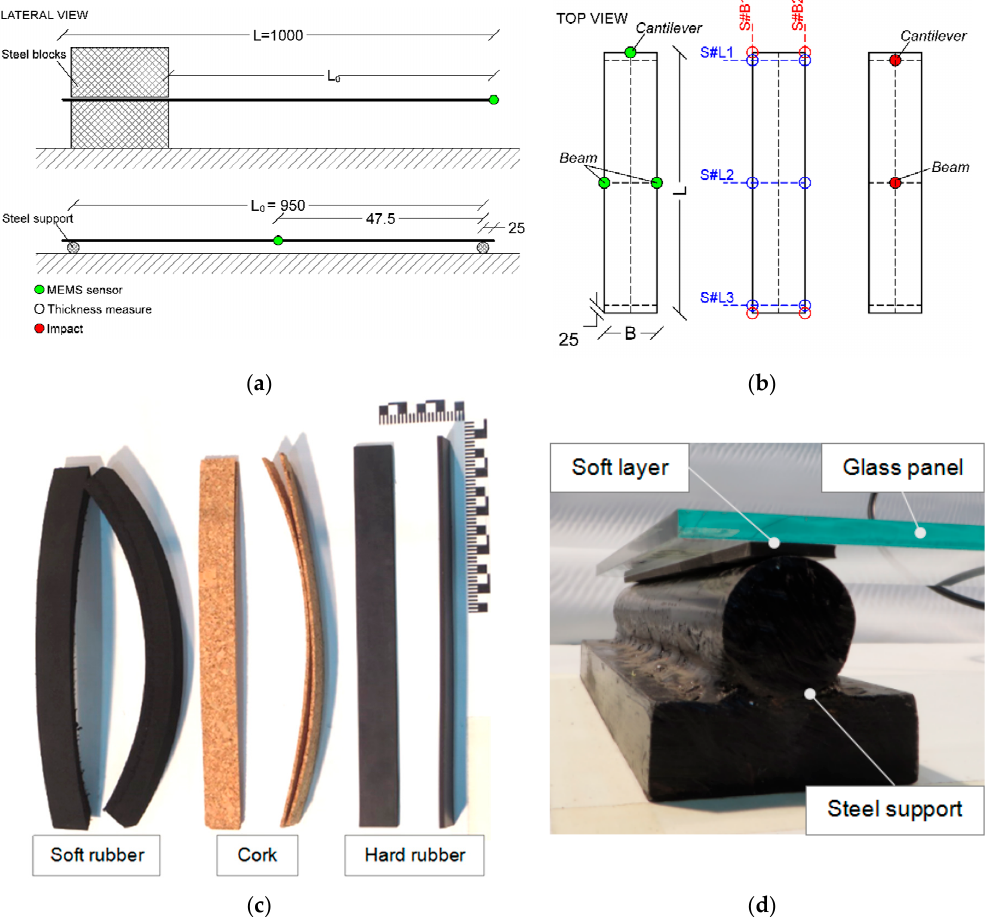
Figure 2. ( a ) Reference test setup (dimensions in mm) and ( b ) key control points for the tested glass panels, with ( c ) view of the soft layers in use and ( d ) example of a typical support detail for a beam-like specimen (hard rubber).